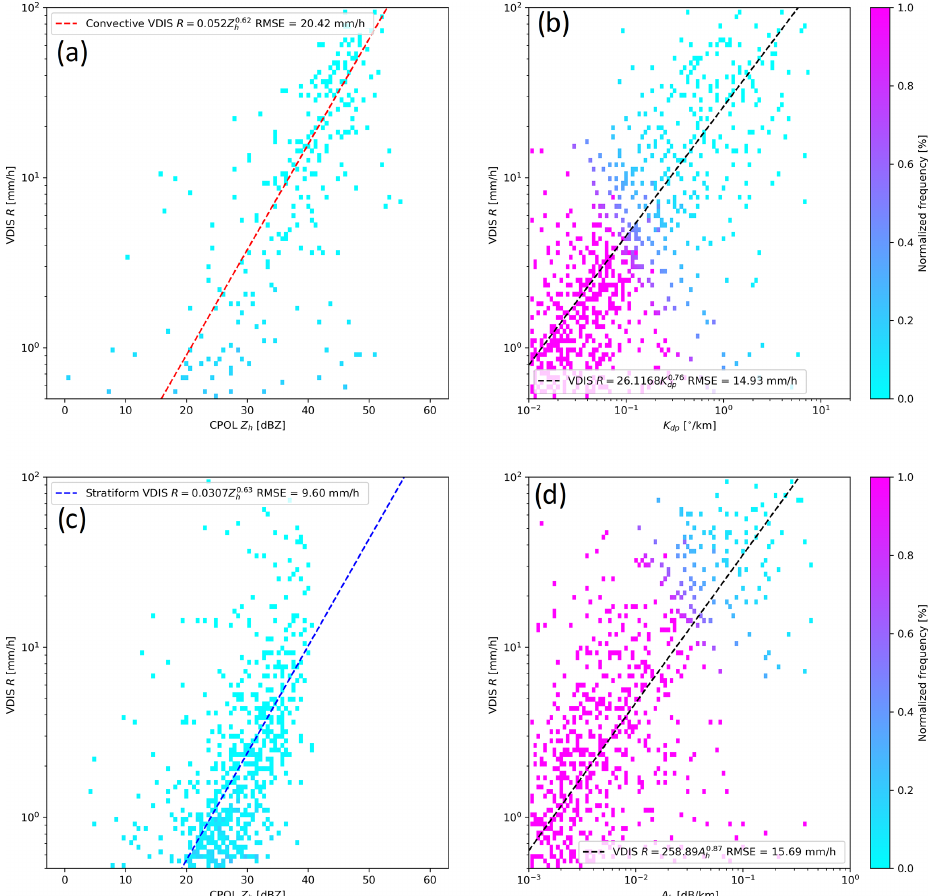
Figure 8. R from the VDIS as a function of (a) Z h for convective DSDs, (b) K d p , (c) Z h for stratiform DSDs, and (d) A h from CPOL. Solid lines are the R estimators in Fig.